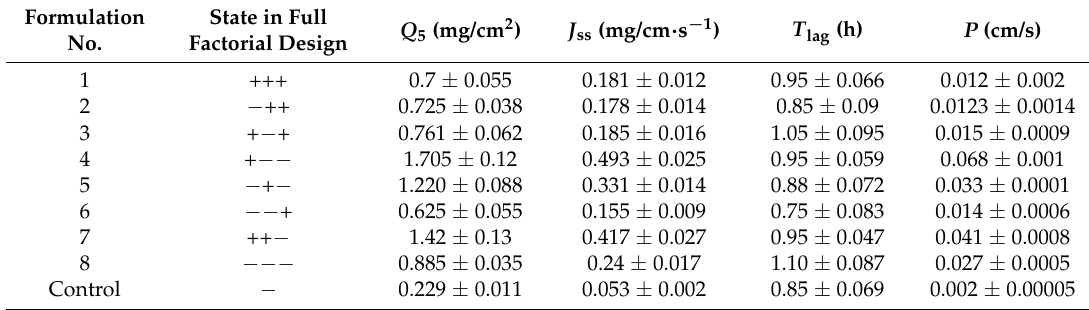
Table 5. Parameter impacts on the permeability of different formulations of propranolol hydrochloride through